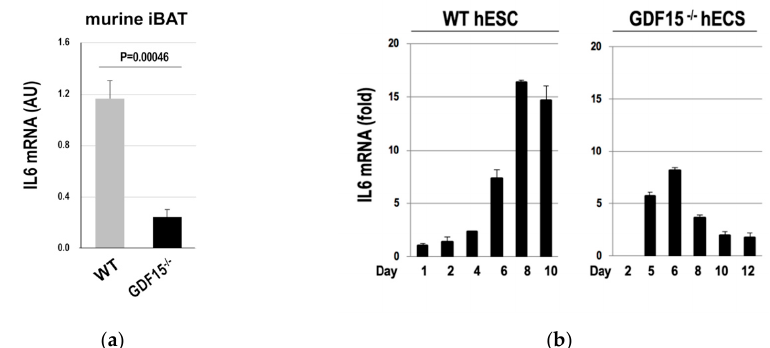
Figure 5. IL6 expressions were reduced by the absence of GDF15 . The expression of IL6 mRNA was measured in the iBATs of WT and GDF15 -/- mice ( n = 3 mice) ( a ) or in the hESCs that were subjected to the differentiation into BAs ( n = 3 experiments) ( b ). Data are shown as mean ± SD.